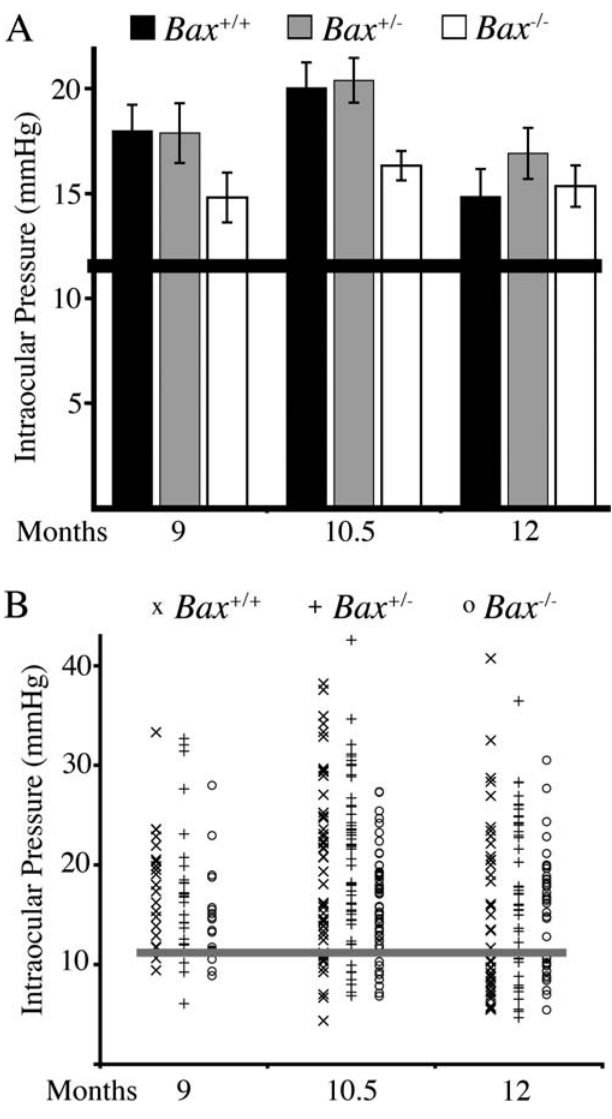
Figure 4. Complete Bax Deficiency Has a Protective Effect against IOP Elevation To assess the possibility that Bax deficiency may delay axon degeneration by lessening the glaucomatous insult to which RGCs are exposed, we analyzed IOP at key ages of IOP elevation. (A) The average IOP for each genotype ( 6 SEM) and (B) the actual IOP values recorded. Bax deficiency did not prevent IOP elevation. At both 9 mo and 10.5 mo, the average IOP of both Bax +/ (cid:1) and Bax (cid:1) / (cid:1) mice was significantly elevated compared to preglaucomatous DBA/2J mice ( p , 0.001). The width of the horizontal line (black in [A], gray in [B]) represents the mean IOP 6 SEM of a group of wild-type preglaucomatous DBA/2J mice that were 3 mo old. The degree of IOP elevation, however, was altered in Bax (cid:1) / (cid:1) mice. In both 9- and 10.5-mo-old Bax (cid:1) / (cid:1) mice, the average IOP was less than that of Bax +/+ and Bax +/ (cid:1) mice. This reduction in IOP elevation was significant at 10.5 mo ( p , 0.01). The IOP of Bax +/ (cid:1) mice did not differ from wild type at either 9 or 10.5 mo ( p . 0.82). By 12 mo, there was no difference in IOP between mice of any genotype ( p .